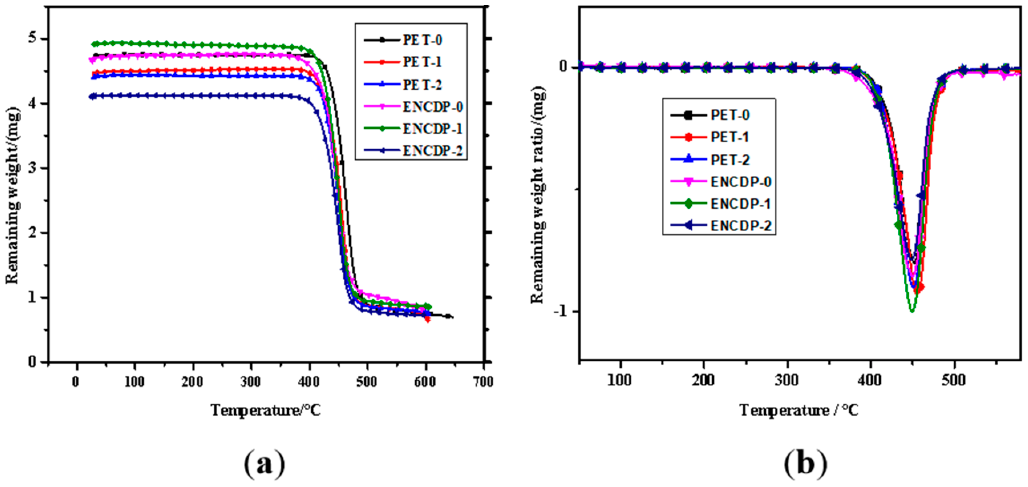
Table 9. Thermogravimetric data for the copolyester.